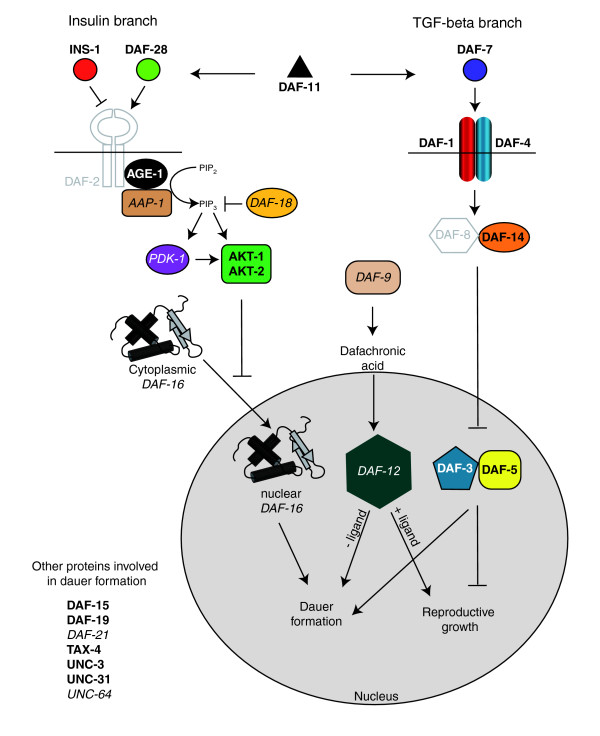
A majority of dauer pathway genes are enriched in either the larval pan-neural (LP) or embryonic pan-neural (EP) datasets. Two neuronal pathways influence the decision to dauer, an alternative developmental pathway adopted in unfavorable conditions [49-54]. During normal growth, the DAF-28 insulin-like molecule activates the DAF-2 insulin receptor to initiate a signal transduction pathway that prevents the translocation of the DAF-16 Forkhead transcription factor into the nucleus, thus blocking dauer formation. In a parallel pathway, DAF-7/TGF-beta activates receptors DAF-1 and DAF-4 to inhibit the Smad/Sno complex DAF-3/DAF-5, thereby promoting reproductive growth. The guanylyl cyclase DAF-11 drives expression of DAF-28 and DAF-7. During reproductive growth, the CYP2 cytochrome P450 enzyme DAF-9 is active and produces the DAF-12 ligand dafachronic acid. In the presence of its ligand, the nuclear hormone receptor DAF-12 promotes normal development. In the absence of its ligand, DAF-12 instead promotes dauer formation. Other proteins function independently of these pathways (for example, the DAF-19 transcription factor specifies ciliated neurons that detect exogenous dauer-inducing signals). Bold lettering denotes enriched transcripts and italics marks EGs detected in at least one of the pan-neural datasets. Gray letters refer to transcripts not found in either EP or LP datasets. See Additional data file 18 for a complete description of these genes.